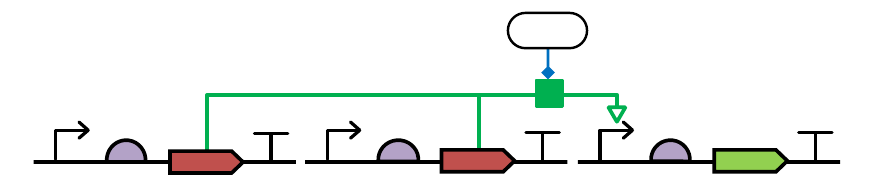
Figure 40: Phosphorylation of an inactive transcription factor (produced by two different CDSs) by a kinase to form an active transcriptional activator, which then stimulates a promoter.